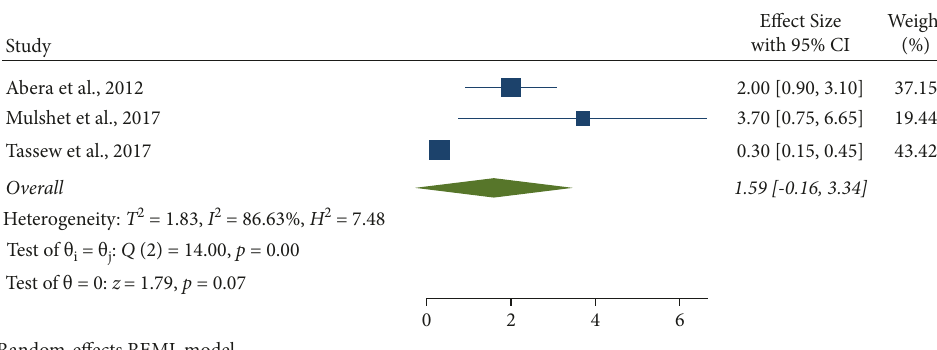
0 2 Figure 13: Floor type as an associated risk factor for mastitis among dairy